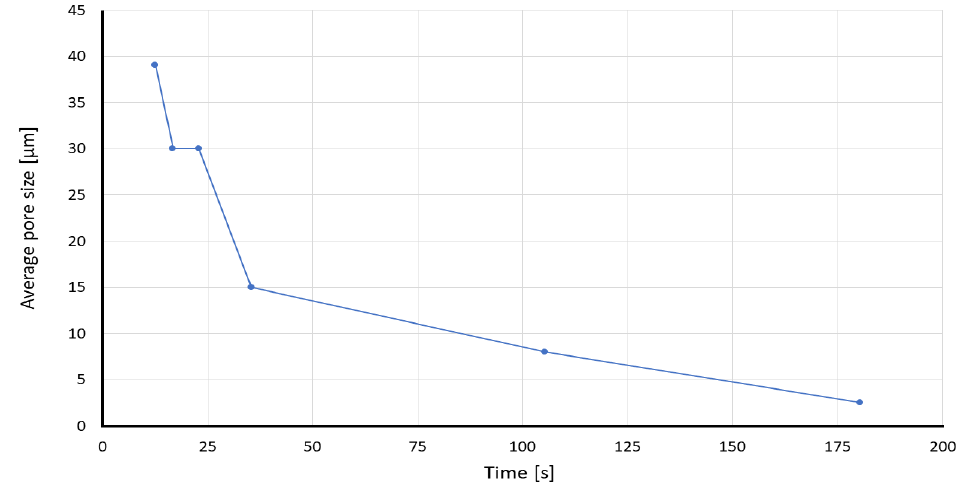
Figure 7. Plot of the average pore size and the time required to develop 1.0 mm diffusion width.